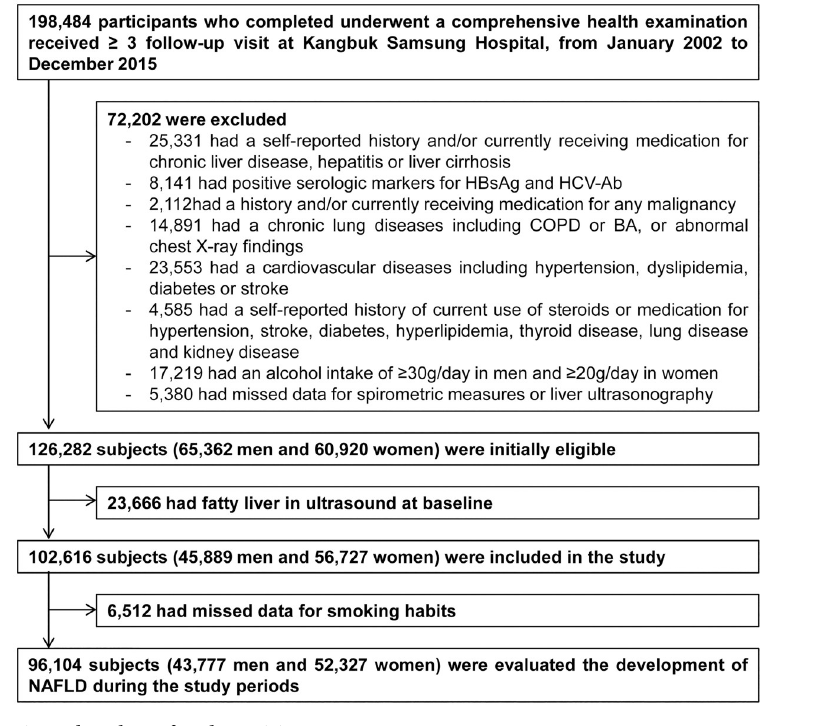
Fig 1. Flow chart of study